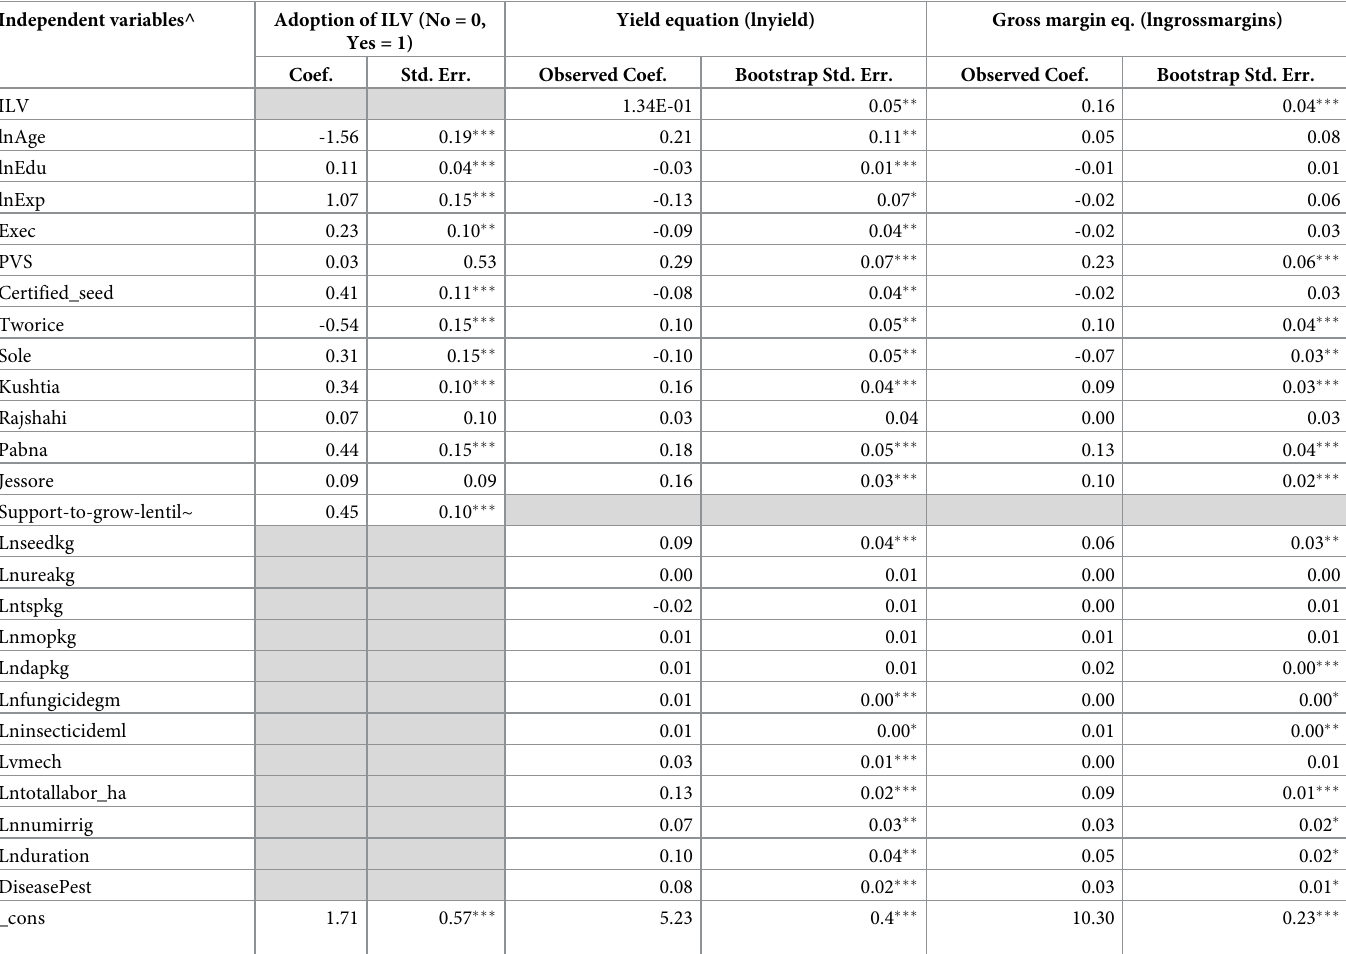
Table 4. Parameter estimates of the instrumental variables model using 2SLS